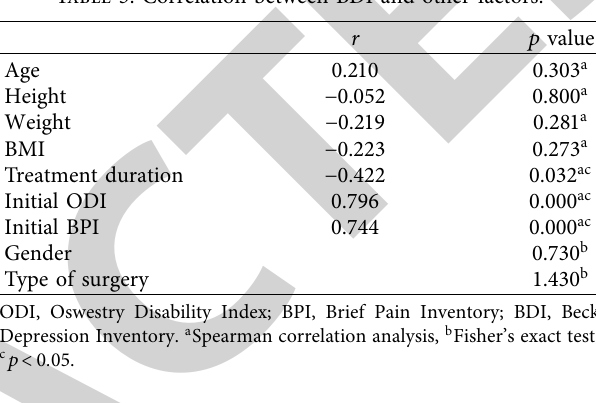
Table 3: Correlation between BDI and other factors.